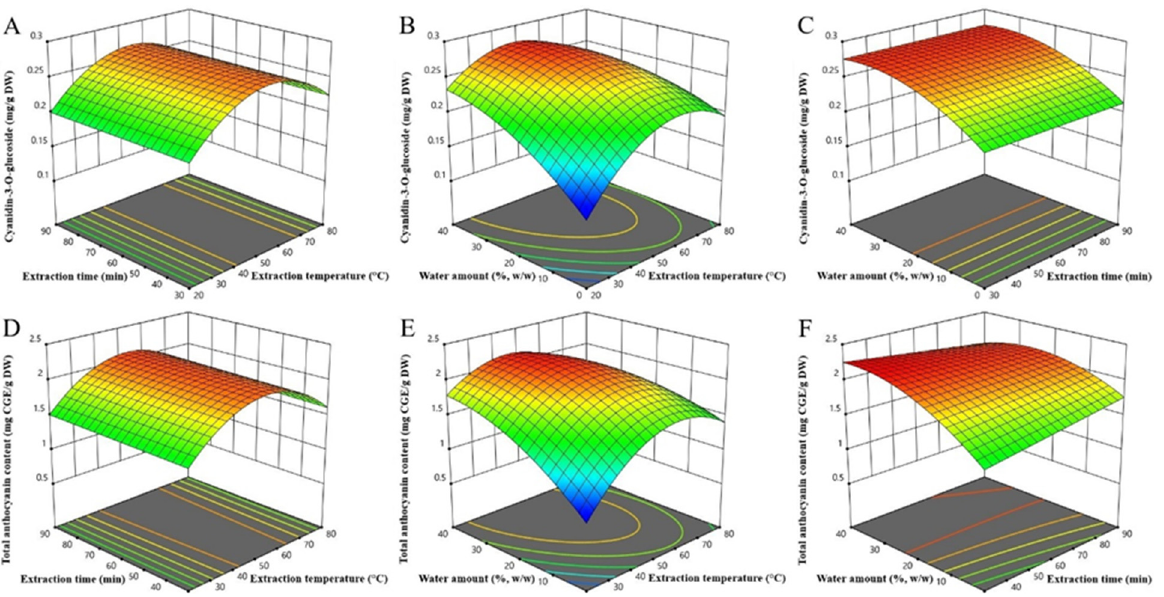
Figure 1. Response surfaces plots (3D) of cyanidin-3- O -glucoside ( A – C ) and total anthocyanins extracted ( D – F ) from bilberry fruits as a function of extraction temperature, time, and water amount in NaDES.